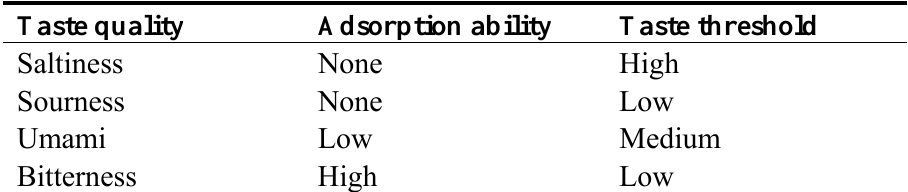
Table 1. Physicochemical properties of taste